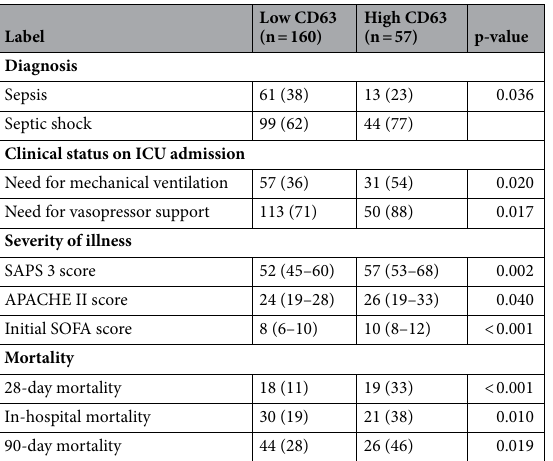
Table 2. Outcomes and illness severity among patients dichotomized by exosomal CD63 level ≥ 126 and < 126 µg/mL. Data are presented as median (interquartile range) or number (%). ICU, intensive care unit; SAPS, simplified acute physiology score; APACHE, acute physiology and chronic health evaluation; SOFA, sequential organ failure assessment.